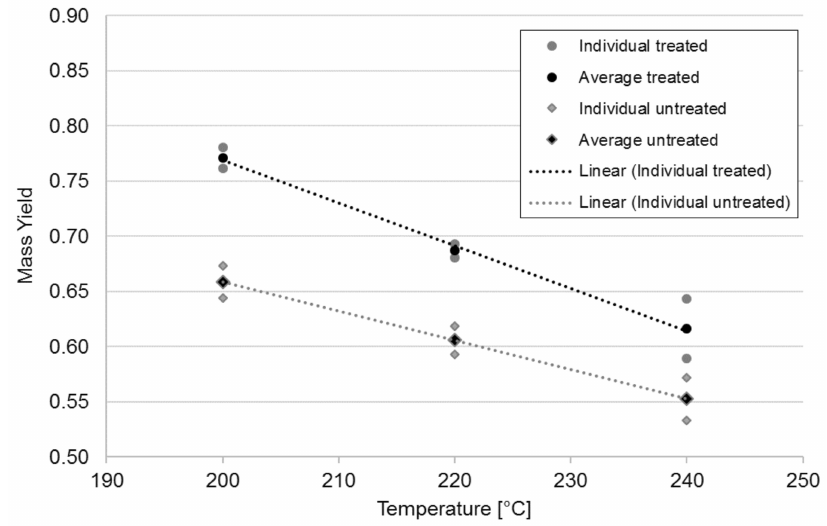
Figure 2. Mass yield of hydrothermal carbonization (HTC) experiments as a function of temperature for untreated and treated wood.